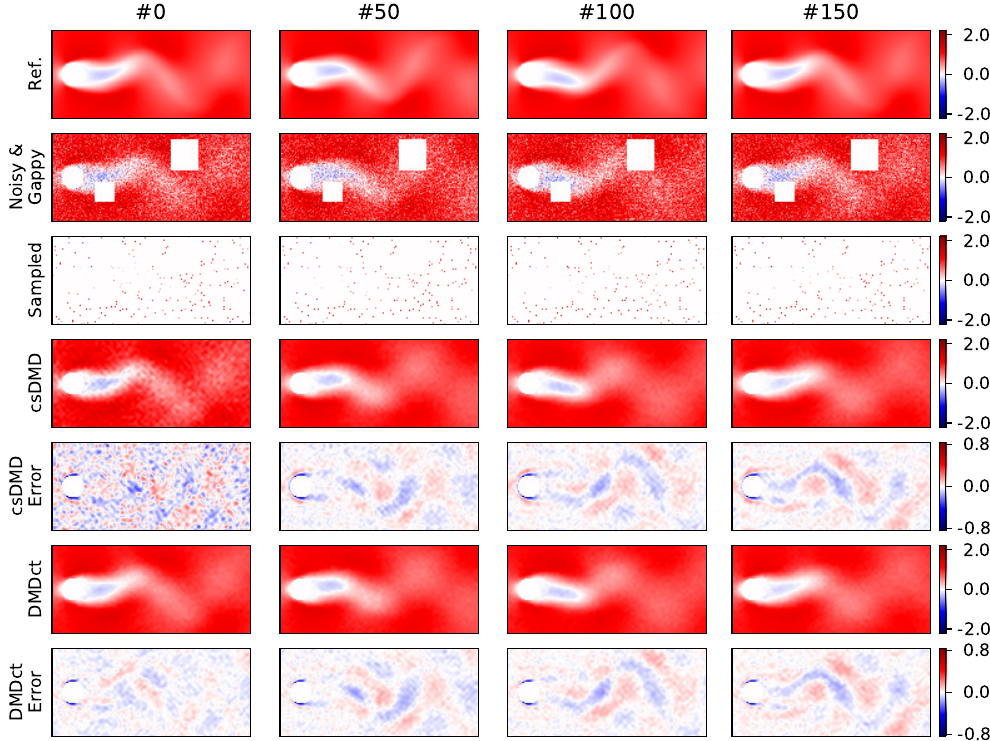
Figure 7. Four sample snapshots of reconstructing the noisy u velocity component of the wake behind a cylinder at Reynolds number Re = 100. The circular hollow represents the cylinder. The top row shows the noise-free reference u velocity component. The second row shows the reference with random Gaussian noise having standard deviation of 0.25 added. The two rectangular gaps are seen as two white rectangular hollows. The third row shows the random samples taken (2% sampling). The fourth and fifth rows show csDMD reconstruction and its error. The two bottom rows show DMDct reconstruction and its